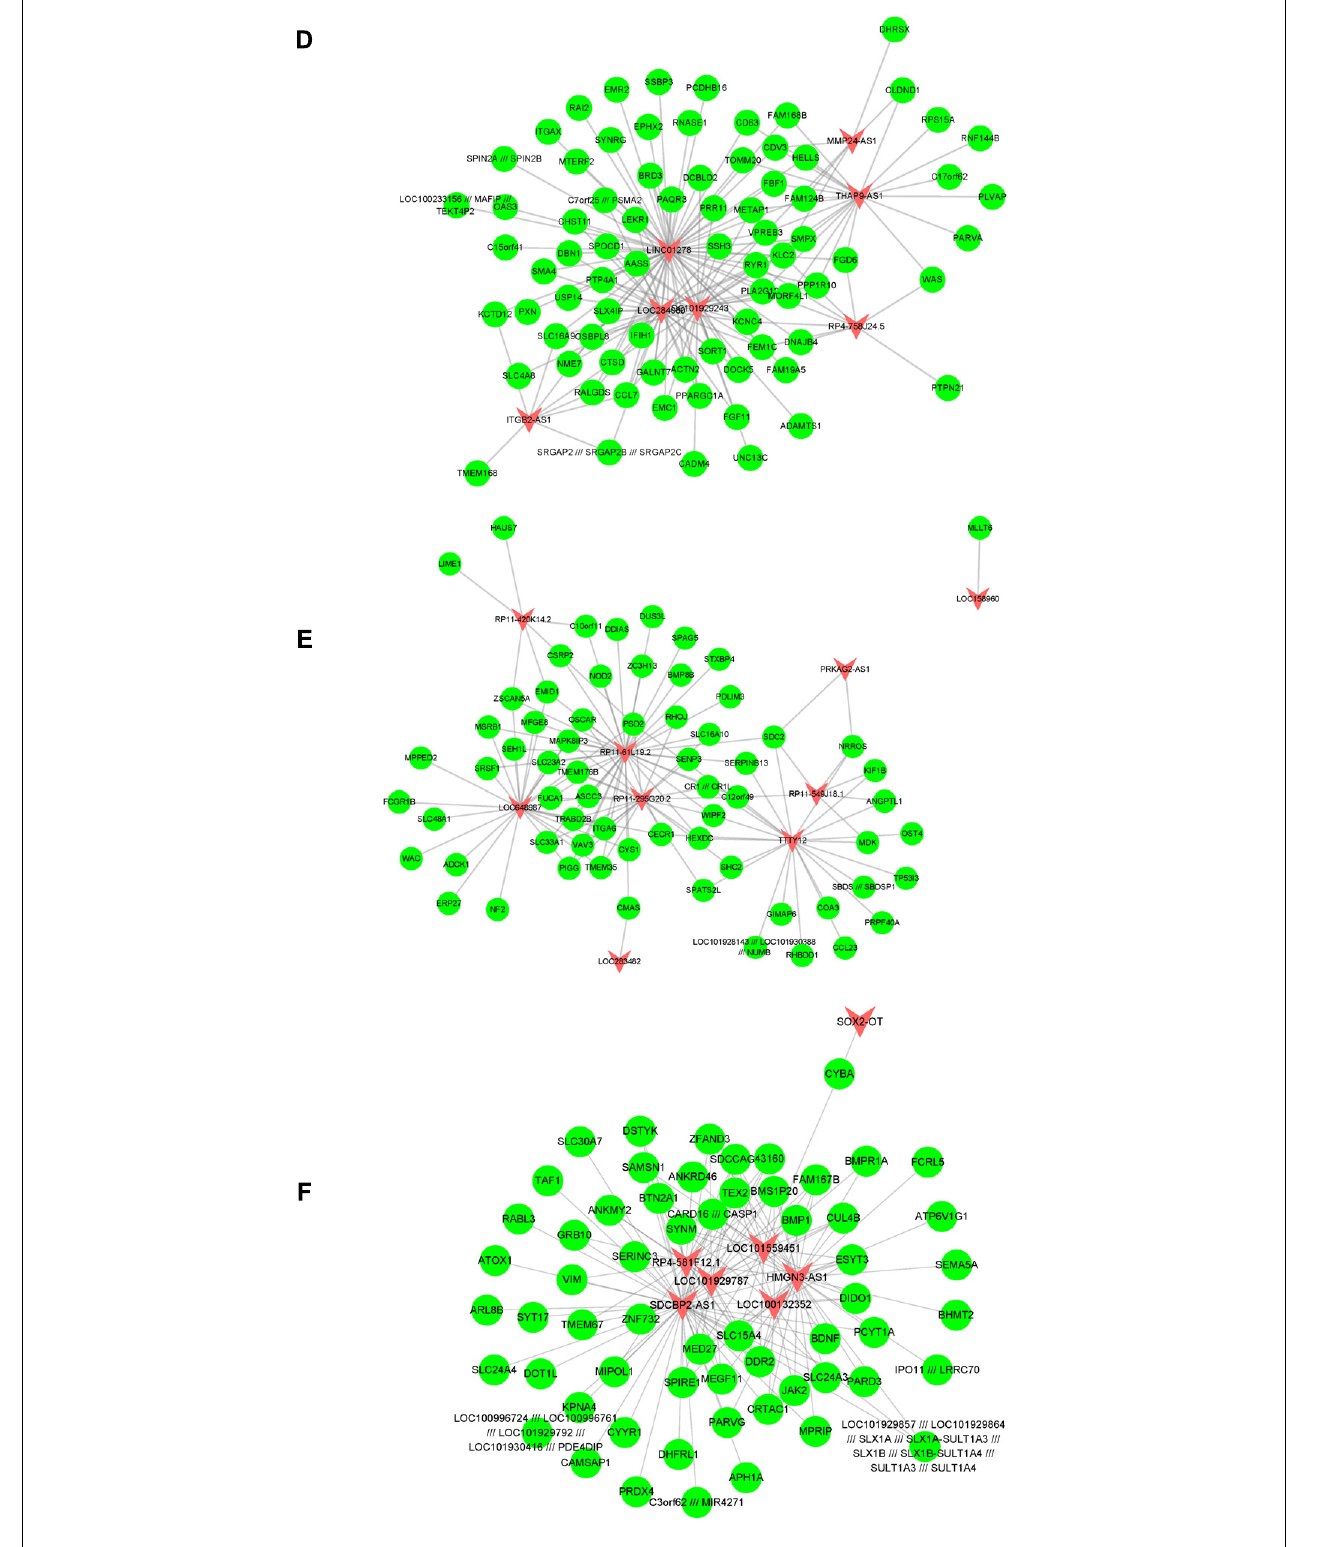
FIGURE 4 | Result of atherosclerosis related lncRNA-mRNA co-expression networks. Construction of module 7–12 lncRNA-mRNA co-expression networks based on WCGNA analysis. (A–F) The co-expression networks of module 7 (A) , module 8 (B) , module 9 (C) , module 10 (D) , module 11 (E) , and module 12 (F) .